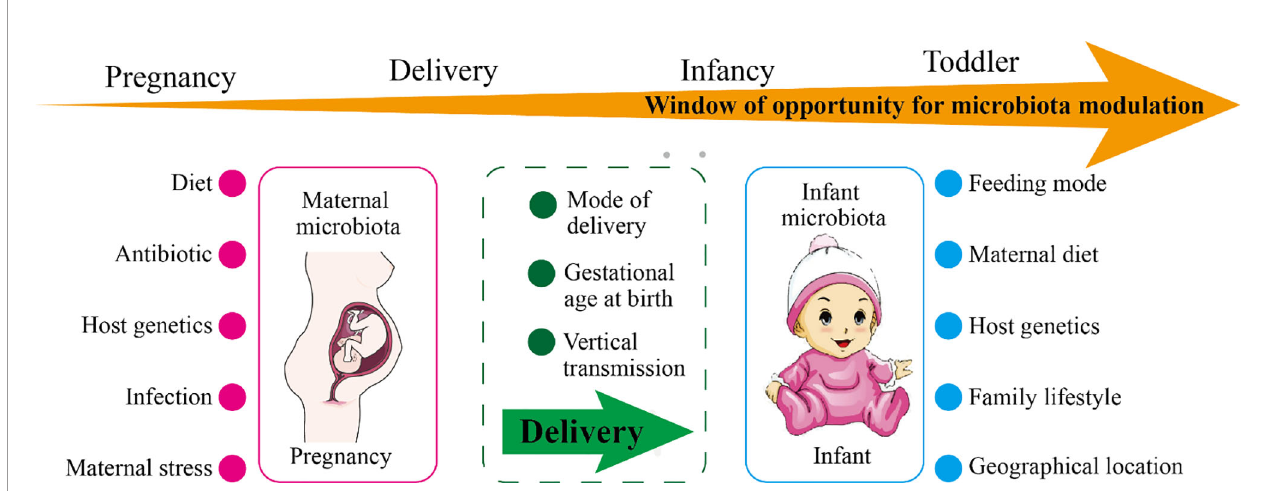
FIGURE 1 | The factors affecting maternal or infant microbiota and the windows of opportunity for microbiota modulation. As shown in the fi gure, the maternal microbiota and the infant microbiota are affected by environmental and genetic factors. During pregnancy, the main in fl uencing factors of the maternal microbiota are diet, use of antibiotics, infection, stress, and host genetics. During delivery, the maternal microbiota will be transmitted vertically to the newborn, and the delivery mode and the gestational age of the newborn at birth affect the colonization of the newborn ’ s microbiota. The main in fl uencing factors of infant microbiota are feeding mode, maternal diet, family lifestyle, geographic location, and host genetics. The window of opportunity for offspring microbiota modulation are pregnancy, delivery, infancy, and toddler.